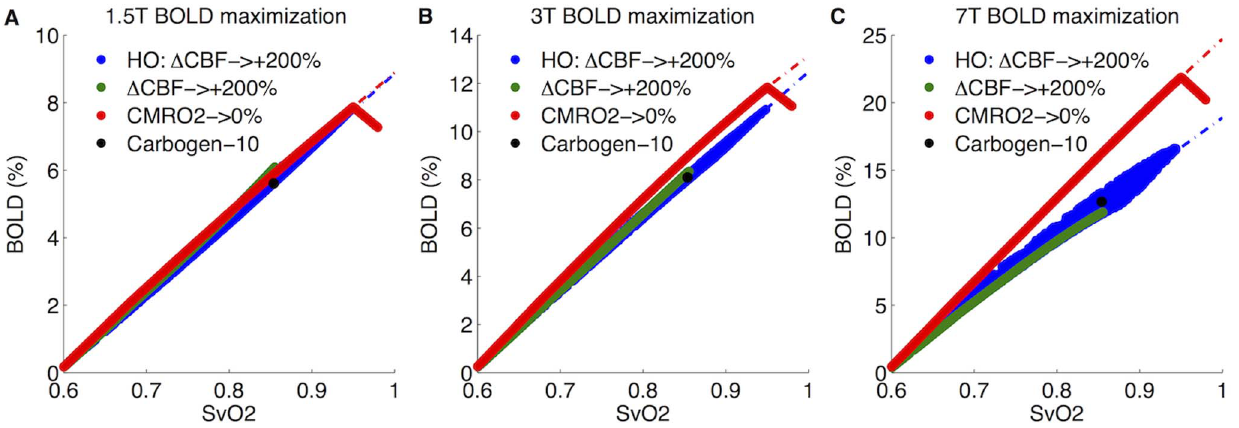
Figure 4. Simulating the maximum BOLD signal through dHb elimination. The maximum BOLD signal results from complete elimination of dHb, which can be accomplished by increasing CBF, decreasing CMRO 2 and/or increasing PaO 2 . Here the BOLD signal is shown as a function of SvO 2 at (A) 1.5T, (B) 3T, and (C) 7T. Three mechanisms of dHb reduction are included: hyperoxia combined with CBF increase (blue), CBF increase only (green) and CMRO 2 cessation (red). Also included is a simulation for D CBF=100% and PaO 2 =390 mmHg consistent with findings from Gauthier et al.